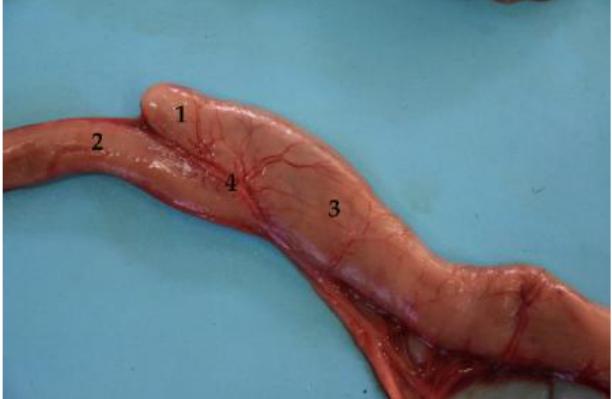
Figure 18. Anatomical relationship between ileum and cecum. ( 1 ) Cecum ( 2 ) ileum (final part); ( 3 ) beginning of the colon; ( 4 ) ileocecal union.